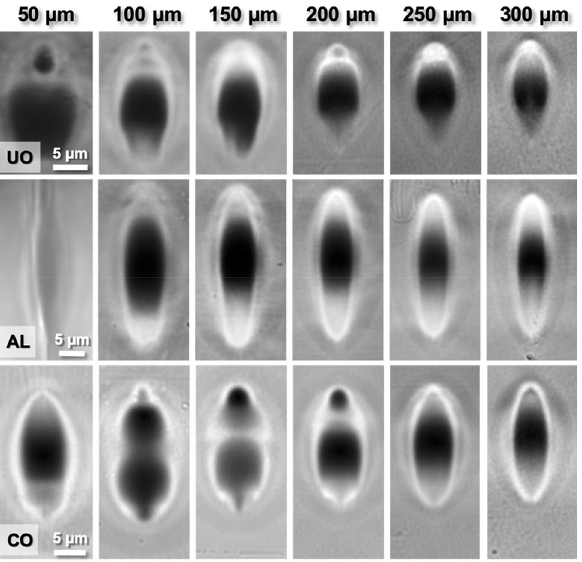
Figure 2. Cross-section transmission optical microscopy images of structures produced with 530 nJ pulses and objective lenses (UO, AL and CO) as labeled at the indicated depths. Scale bars apply to the images of each objective